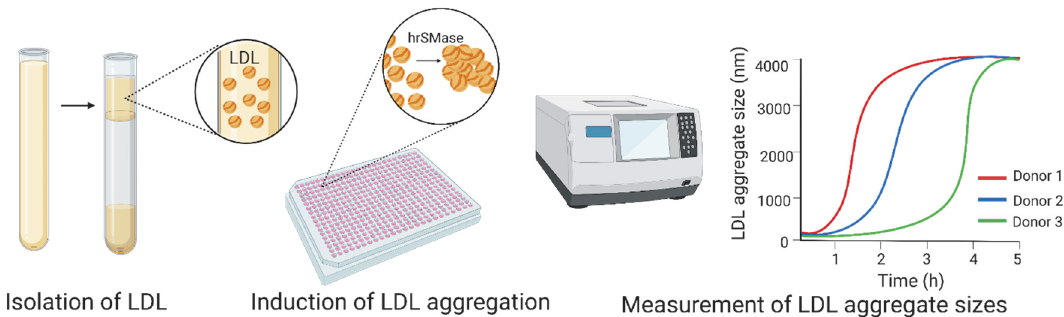
Figure 1. To determine low-density lipoprotein (LDL) aggregation susceptibility, LDL particles are first isolated by ultracentrifugation at a density of 1.019–1.063 g/mL. LDL aggregation is induced by the addition of human recombinant SMase, and LDL aggregation is then followed by monitoring the increase in LDL aggregate size by dynamic light scattering. LDL aggregation susceptibility is reported either as the average size of LDL aggregates at a certain time point or as the inflection point of the aggregate size vs. time curves [37,86]. hrSMase: human recombinant sphingomyelinase. Image created with BioRender.